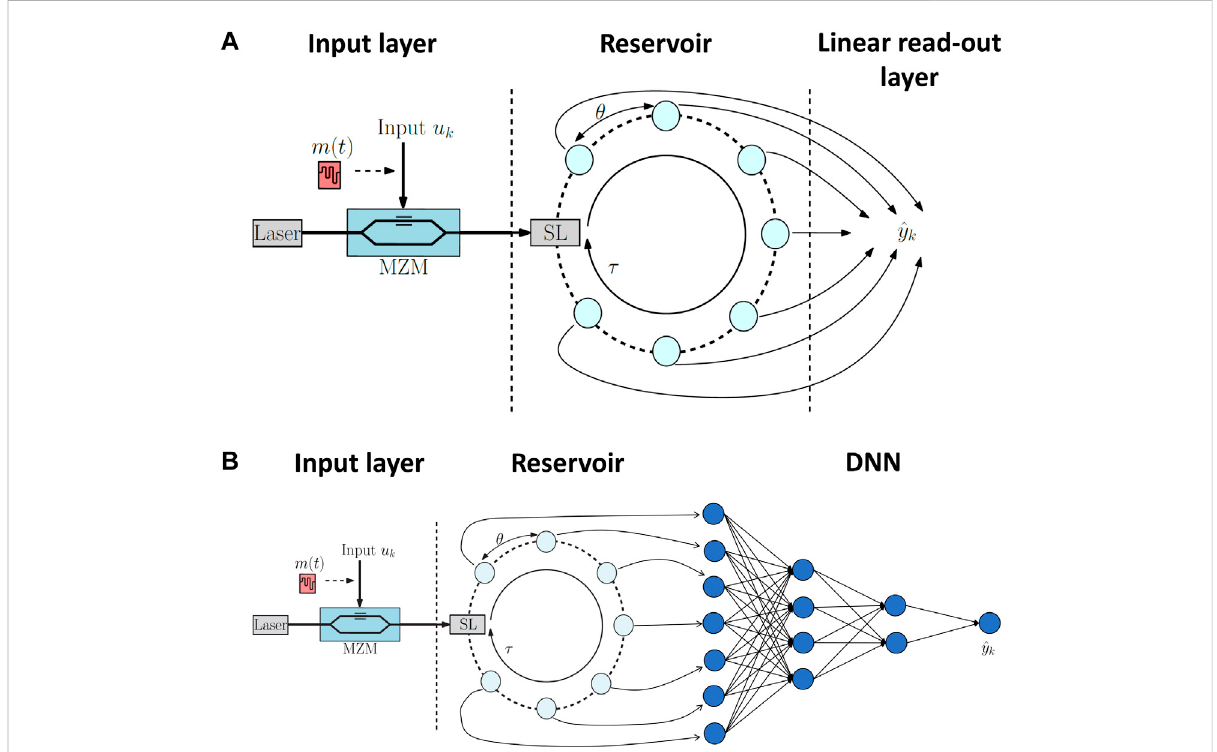
FIGURE 2 Simpli fi ed architecture of a delay-based reservoir computing system, with the input layer, reservoir and linear read-out layer. SL represents the semiconductorlaser,drivenbyaconstantpumpcurrent.Intheinputlayer,amask m ( t )encodestheinputsample u k ,whichisinturninjectedintothe reservoir using a Mach-Zehnder modulator (MZM). In the reservoir, we have a node separation θ and a delay time τ , the virtual nodes are depicted by the cyan circles. In the linear read-out layer, we show the predicted target data ^ y k . (A) . Simpli fi ed representation of the network architecture of the reservoir, functioning as preprocessor, coupled to the DNN, with its nodes depicted by blue circles (B)